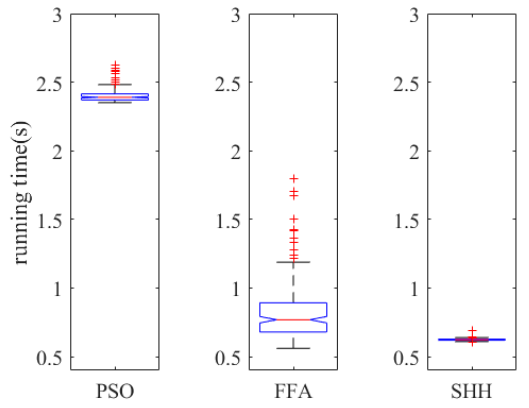
Figure 11. Comparison of the stability of running time of PSO, FFA and SHH algorithms.